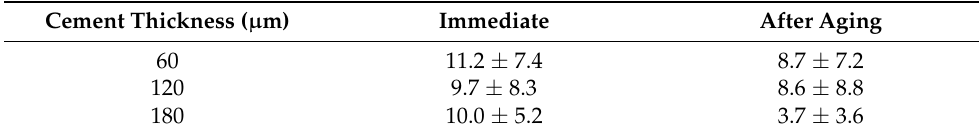
Table 2. Means (in MPa) and standard deviations ( ± value) of the µ TBS Test.